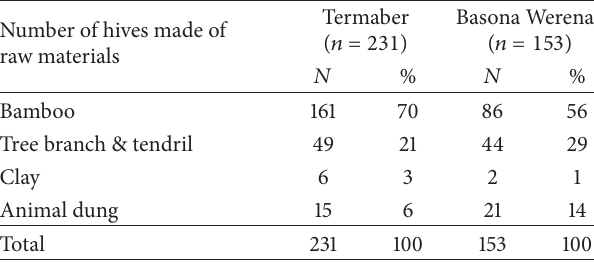
Figure 3: Status and trend of hive transformation in the study area (source: Termaber and Basona Werena Agriculture Office, 2014). Table 4: Materials for traditional hive